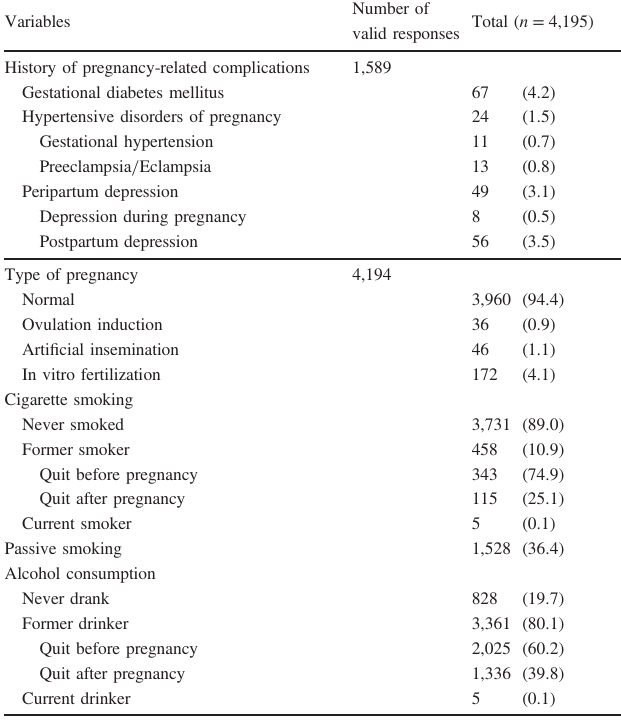
Table 3. Baseline characteristics of the study participants